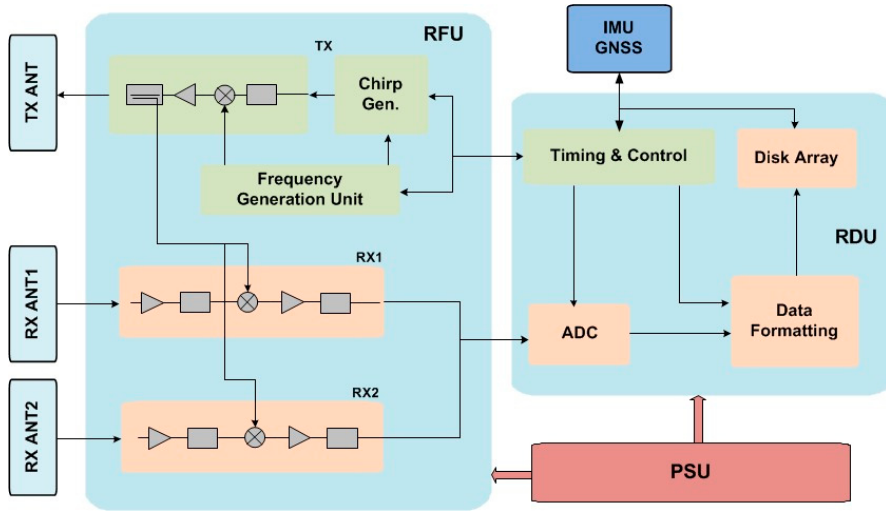
Figure 6. Block diagram of the AXIS system.